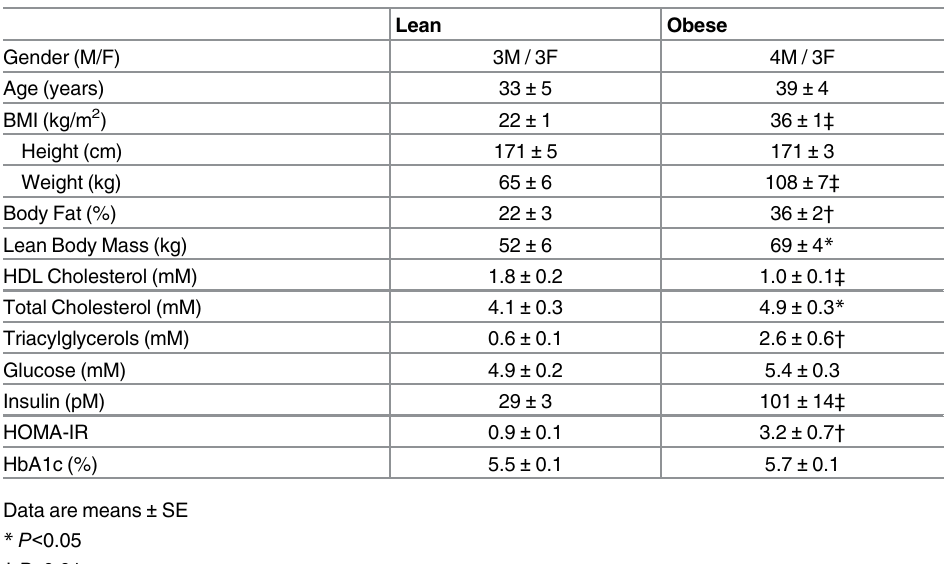
Table 1. Subject